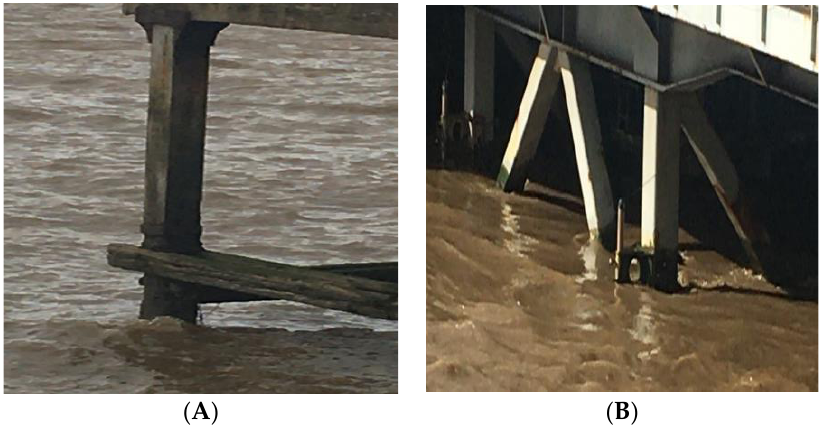
Figure 1. Traditional piles have several issues when placed in marine and other corrosive environ- ments. ( A ) Degradation of concrete piles, and ( B ) corrosion of steel piles .